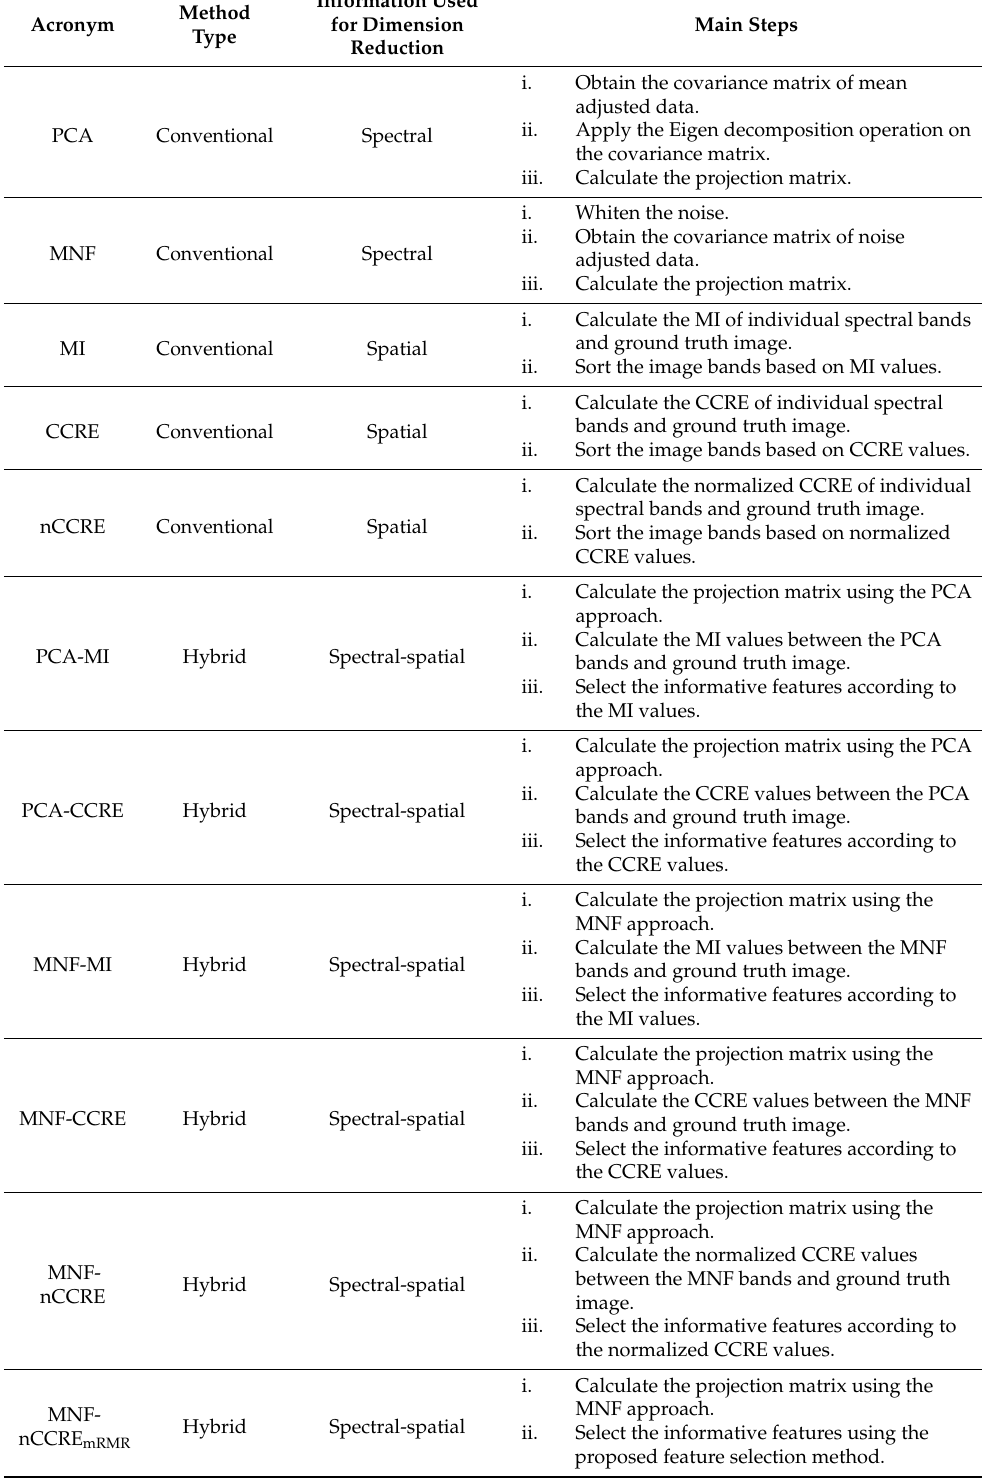
Table 2. Description of different studied and proposed